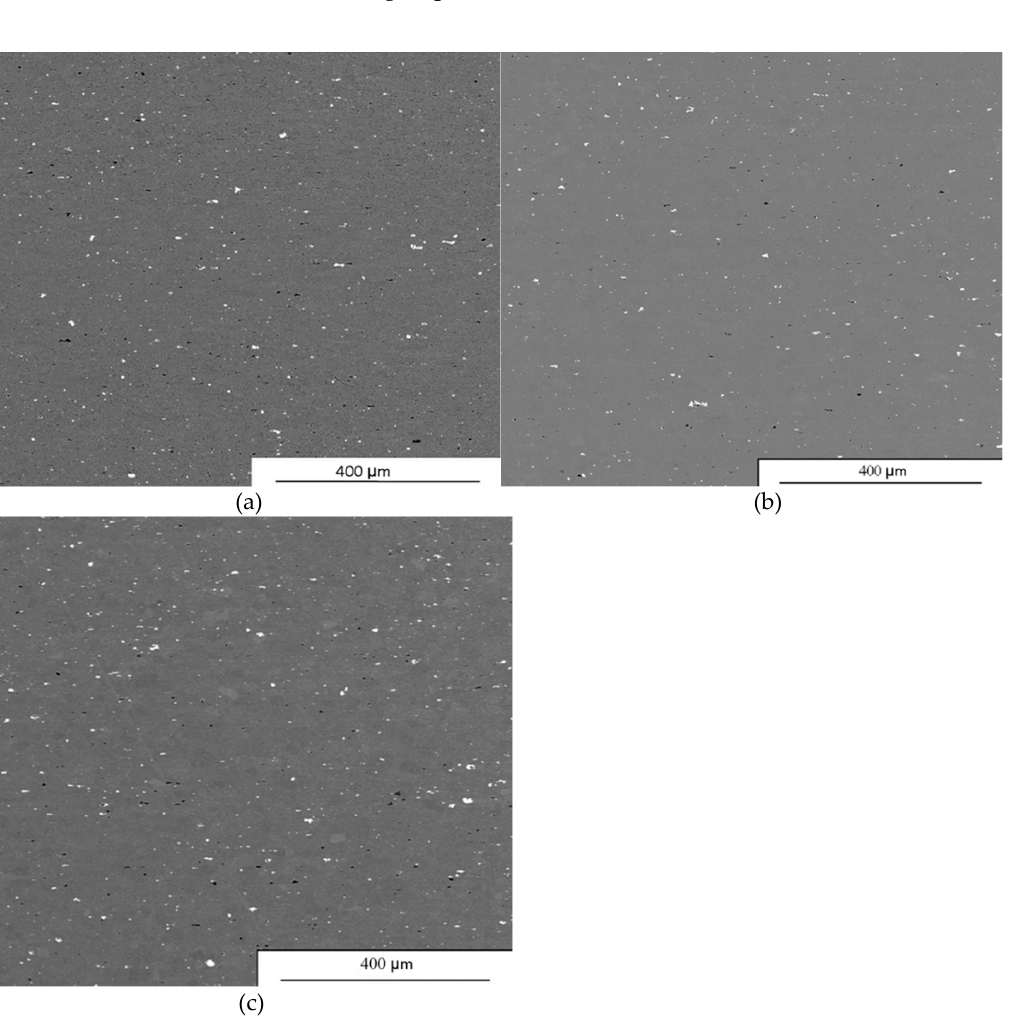
Figure 8. Intermetallic compounds after annealing ( a ) 250 °C, ( b ) 350 °C and ( c ) 500 °C. Fine particles behave in a similar manner as large ones. At the temperature of 250 ◦ C (Figure 9a, a large number of dark fine particles that can be attributed to Mg 2 Si, as